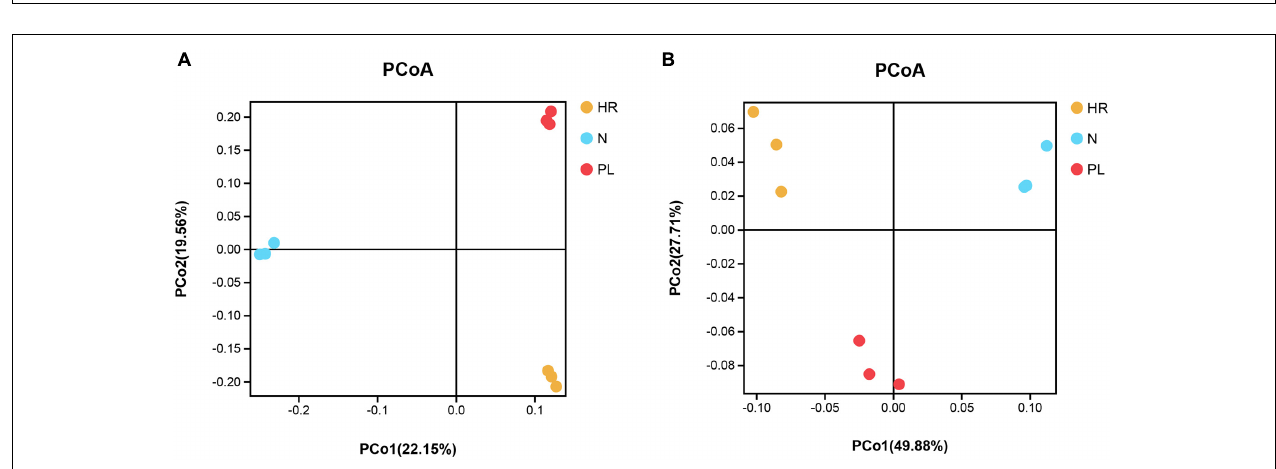
FIGURE 5 | Principal coordinates analysis (PCoA) based on the unweighted UniFrac (UU) and weighted UniFrac (WU) distances among different rhizospheric soil bacterial communities of β -diversity: (A) UU distance; (B) WU distance. Symbols with unique colors denote different samples: yellow circle for HR, soil from the C. yanhusuo field that had been flooded in July 2020; blue circle for N, soil from the C. yanhusuo field without rotation; red circle for PL, soil from the field under peanut– C. yanhusuo rotation).